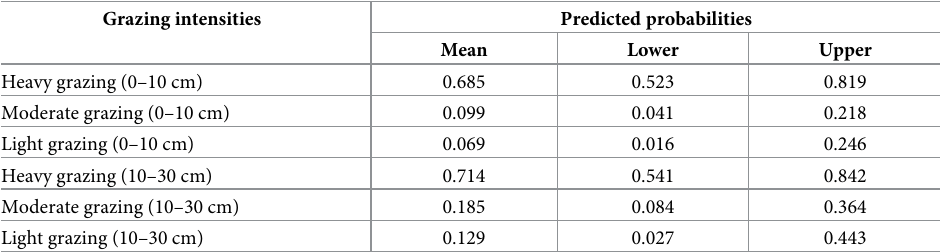
Table 2. Means of the 15 predicted probabilities and their 90% CIs at the 0–10 cm depth and the 6 at the 10–30 cm depth for each grazing intensity resulting in overgrazing based on the logistic model (the dependent variable is binary “overgrazing” and